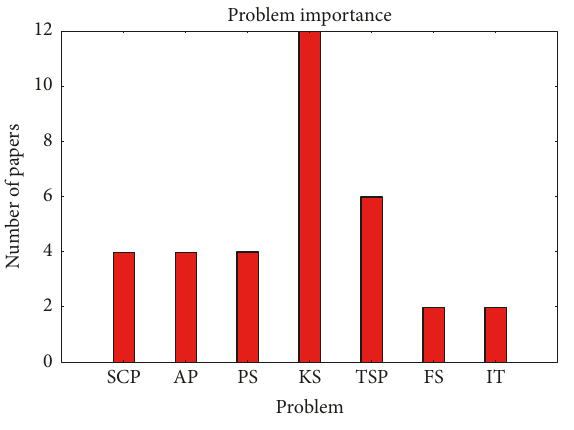
Figure 7: Number of papers by problem. Table 3: Classification summary of binary approach.